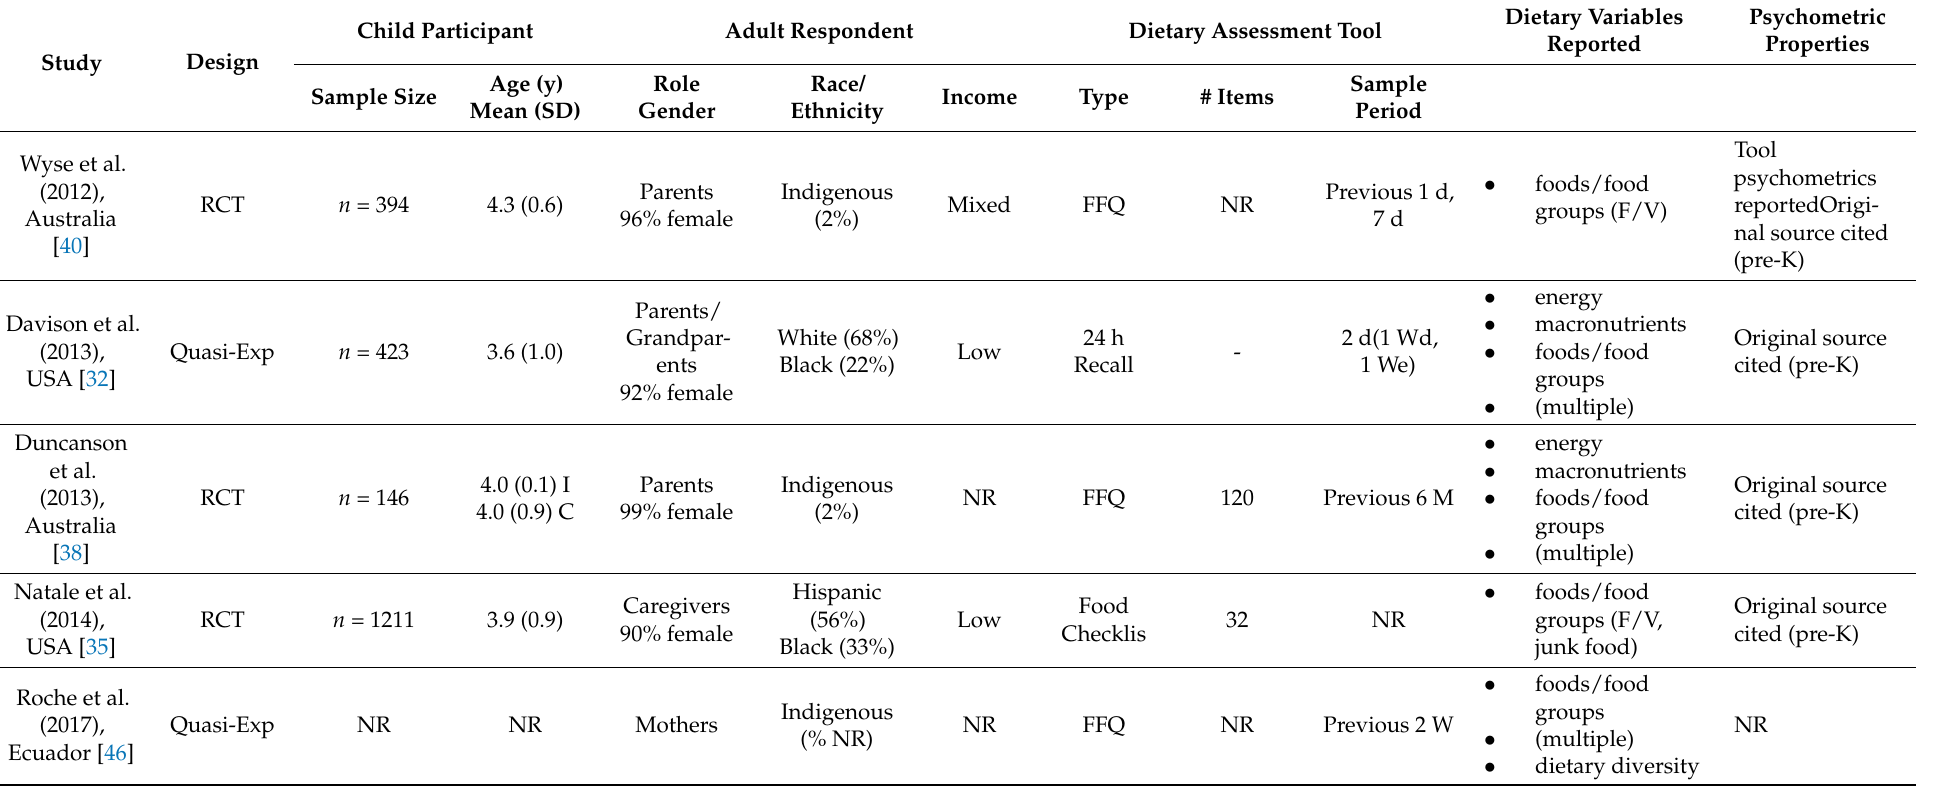
Table 2. Intervention studies and dietary assessment tools used to measure young children’s diet in the home environment ( n =